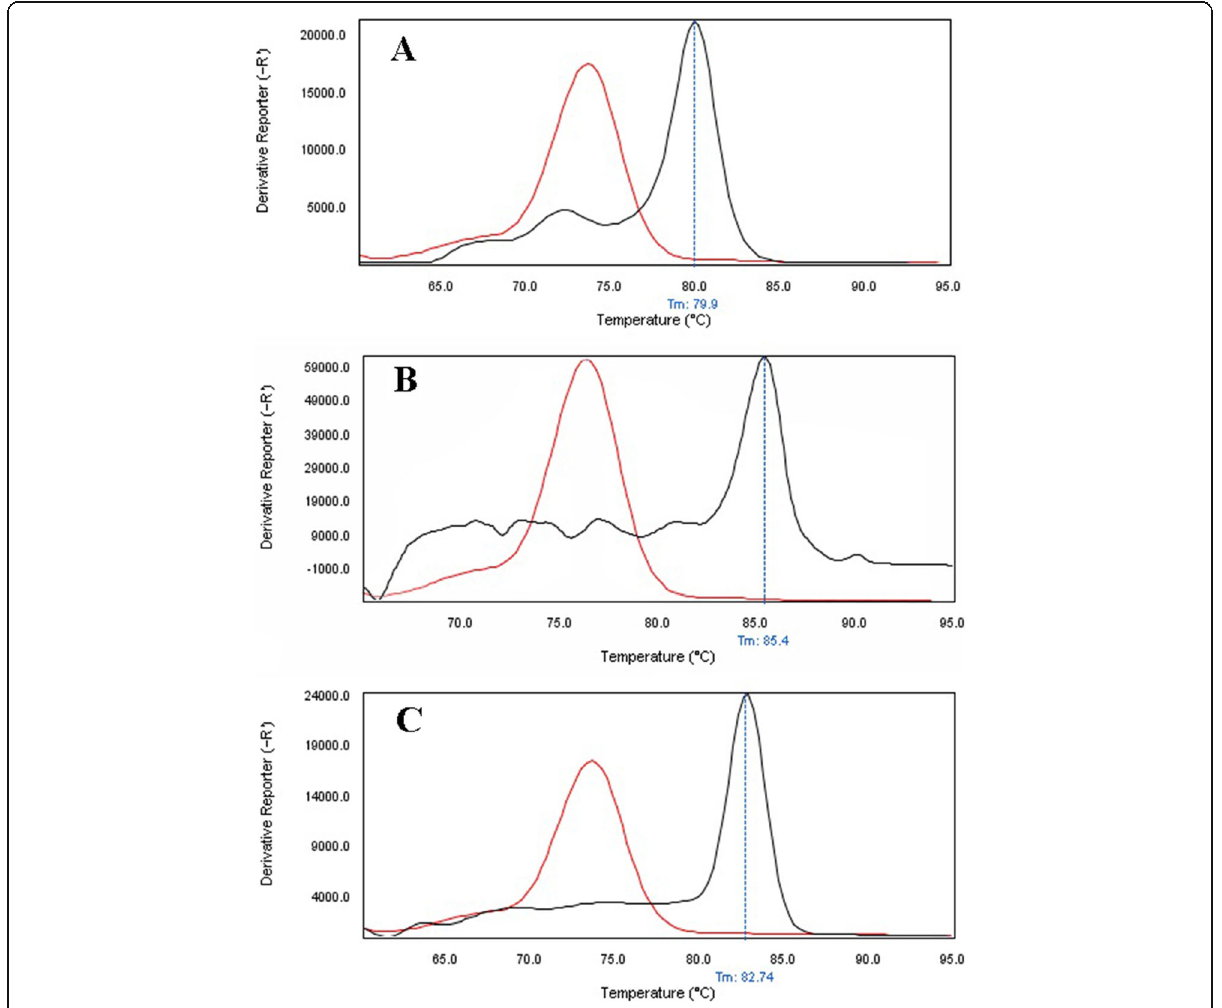
Fig. 4 Specificity of real-time PCR for primers used to detect of E. faecalis , E. faecium , and VRE stains. Melting curve analysis showing the melting temperature peaks (Tm) of E. faecalis ( a ), E. faecium ( b ), and VRE stains ( c ). a blacks ’ lane, E. faecalis NCTC13779 ; red lane, Streptococcus pneumoniae ATCC49619 . b blacks ’ lane, E. faecium NCTC7174 ; red lane, Streptococcus pneumoniae ATCC49619 . c blacks ’ lane, VRE strains; red lane, Streptococcus pneumoniae